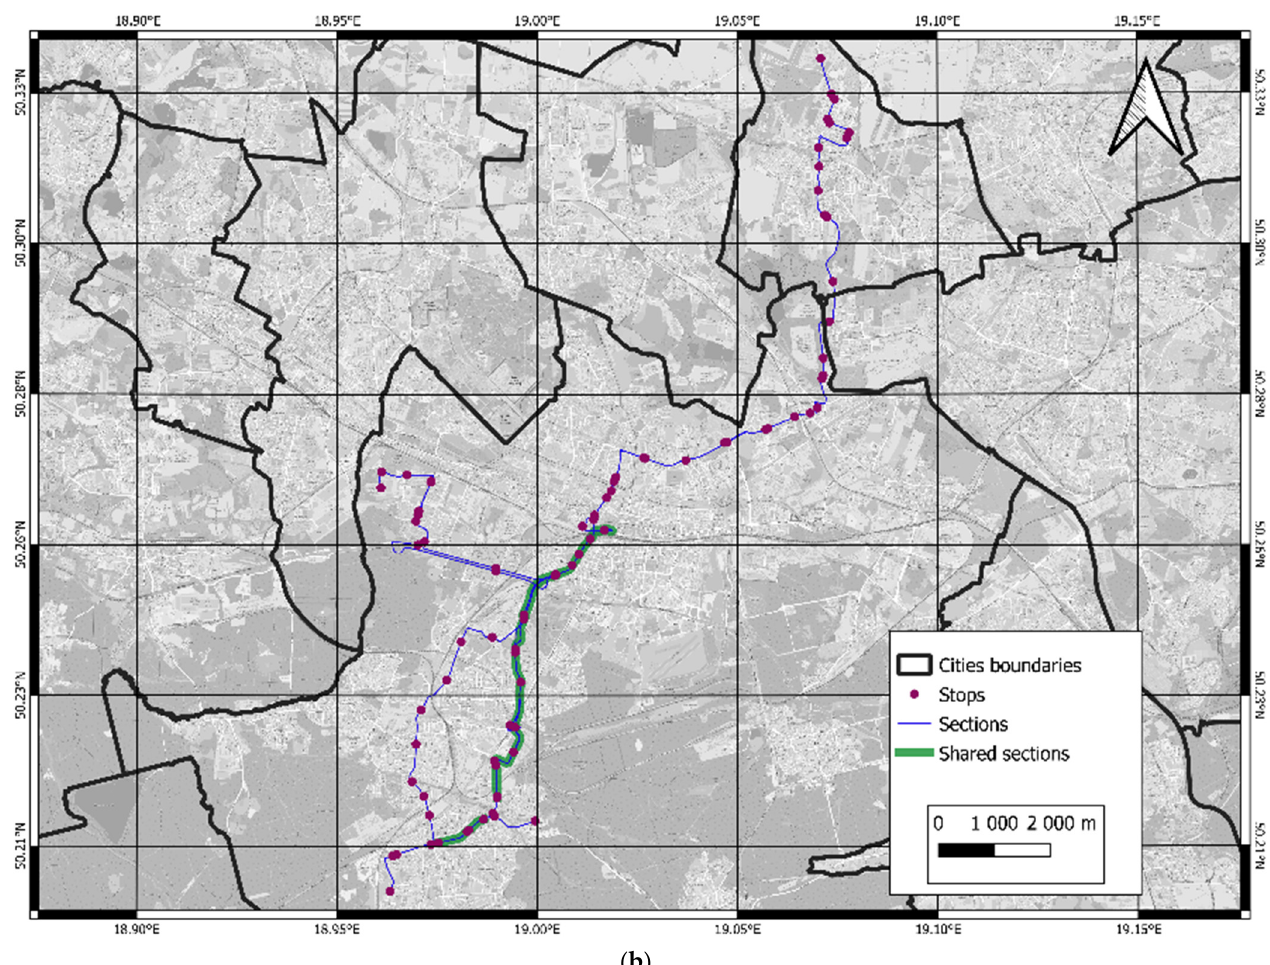
Figure 2. The area served by the tested lines: ( a ) the cities against the background of the Silesian Voivodeship and GZM; ( b ) the routes of the examined lines.